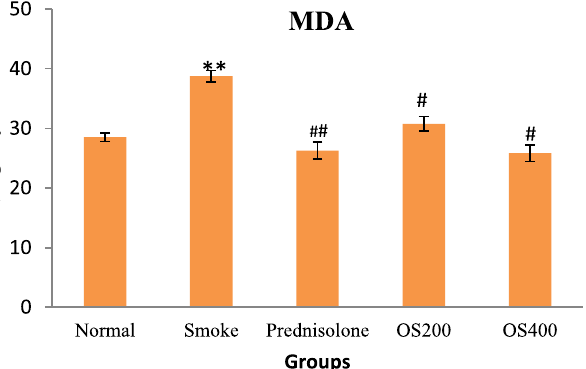
Figure 6. Effect of OLE on MDA level in CS exposed mice: OLE decreased the level of MDA in lung tissue in CS − induced mice where 400 mg/kg was significantly more effective. Values are expressed as mean ± SEM. Results were analysed statistically by one − way ANNOVA followed by Turkey’s test. **p < 0.05 versus the normal group; # p < 0.01 and ## p < 0.05 versus the COPD group.